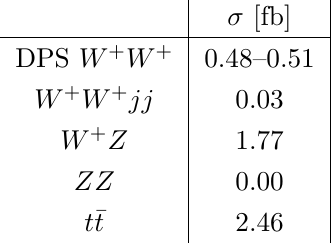
Table 1 . Signal and background cross sections in fb for the production of two positively charged muons for the Final Selection (5.1). The signal cross section depends on the correlation scenario and varies (cid:6) 3% around 0.495 fb.